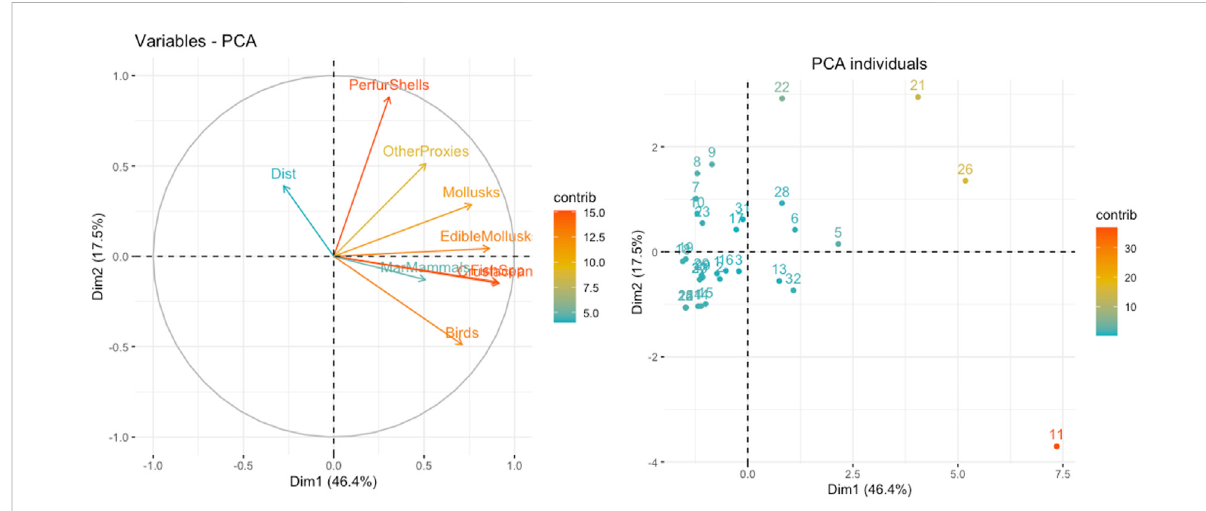
FIGURE 3 PCA Biplot of Dimensions 1 and 2. For site code, see Table